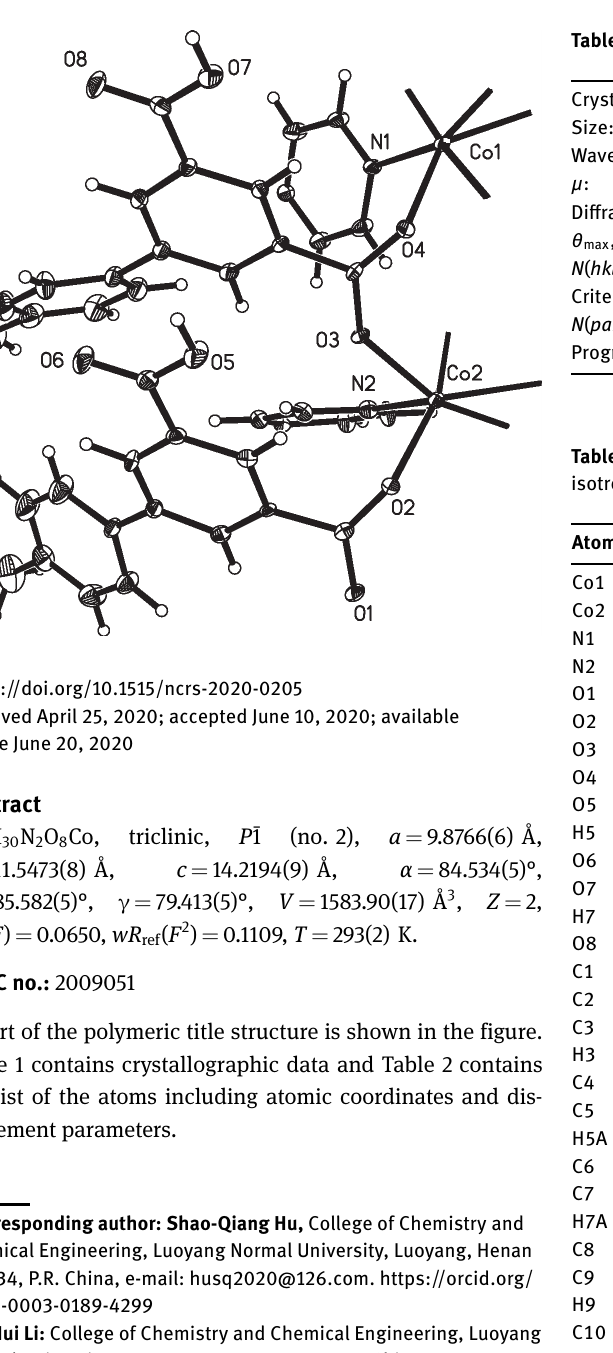
the list of the atoms including atomic coordinates and dis- placement parameters.